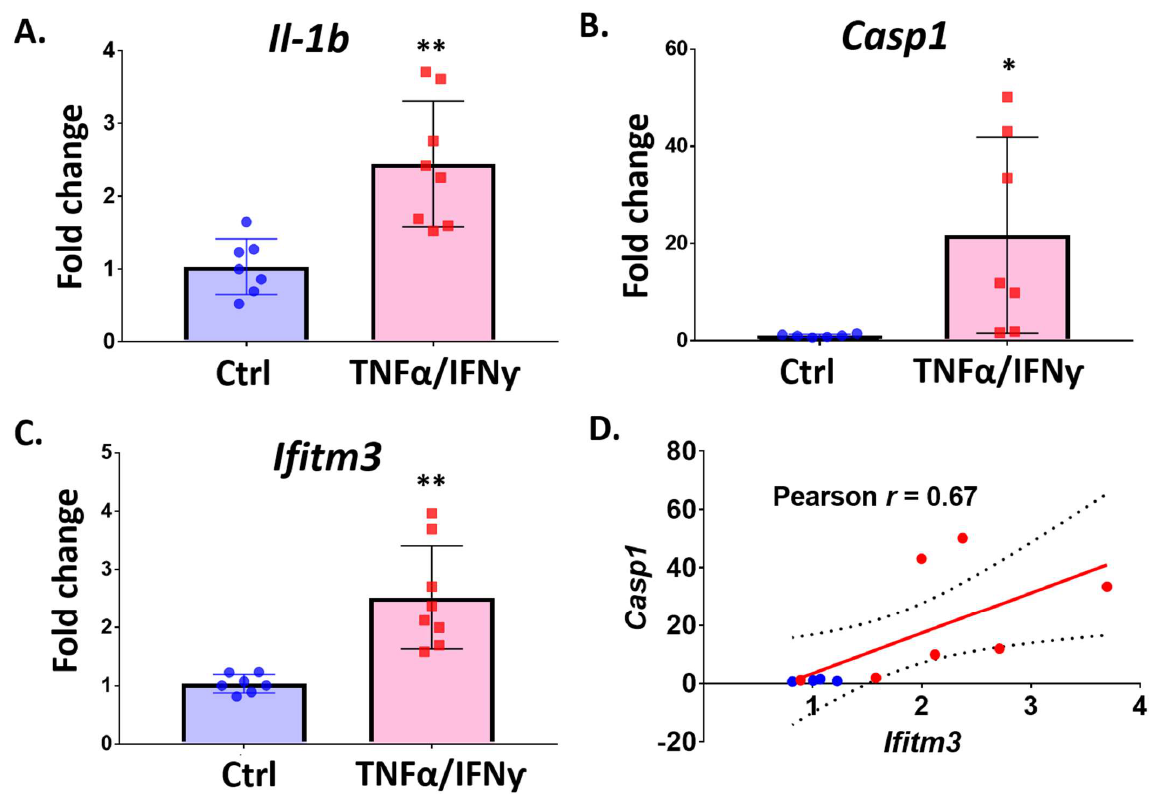
Figure 6. The expression of Ifitm3 and inflammasome related genes is increased by TNFα and IFNγ in primary microglia. Primary microglia were treated with TNFα and IFNγ (20 ng/mL) for 24 h. qRT-PCR was performed to measure gene expression for Ifitm3 and inflammasome related genes ( Casp1 and Il1b ). ( A ) The level of Il1b , an inflammatory marker gene, was increased by TNFα and IFNγ ( n = 7–8, ** p < 0.01 compared to control, two-tailed unpaired Student’s t -test). ( B ) The level of Casp1 was increased by TNFα and IFNγ ( n = 4–8, * p < 0.05 compared to control, two-tailed unpaired Student’s t -test). ( C ) Ifitm3 level was significantly increased by TNFα and IFNγ ( n = 7–8, ** p < 0.01 compared to control, two-tailed unpaired Student’s t -test). ( D ) Correlation analysis showed a close correlation between Ifitm3 and Casp1 expression (r = 0.67, blue dots-Ctrl, red dots-TNFα/IFNγ). To determine if TNFα and IFNγ treatment can induce IFITM3 protein in primary microglia, we treated primary microglia with TNFα/IFNγ and performed western blot analysis. As shown in Figure 7, 24 h exposure to TNFα/IFNγ resulted in significant induction of IFITM3 protein in primary microglia ( n = 6, p < 0.01).